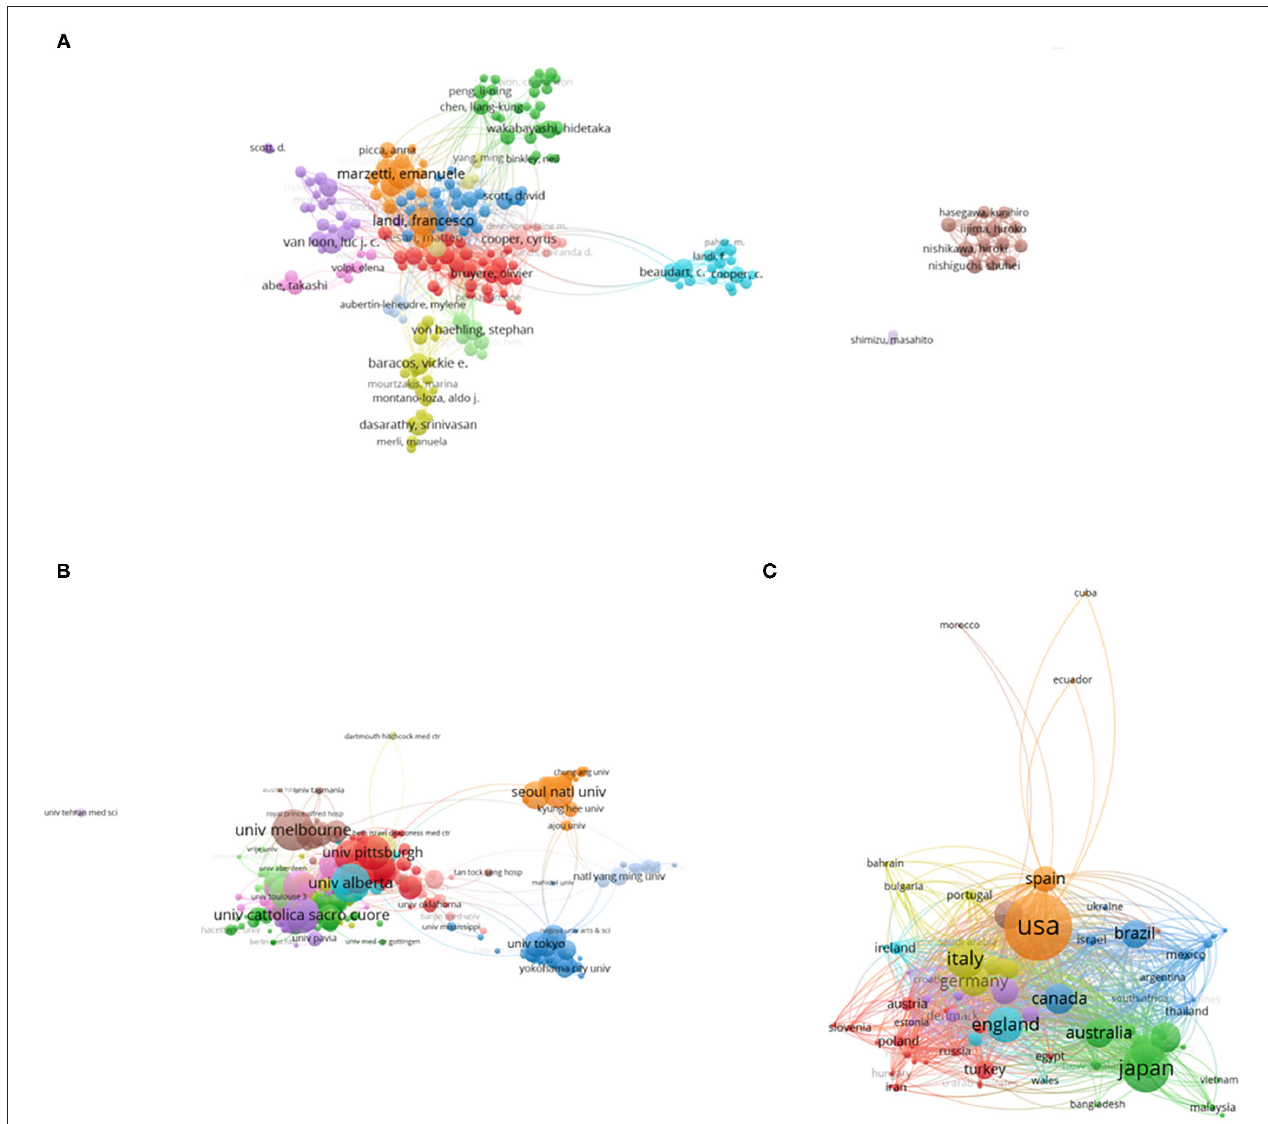
FIGURE 7 | Co-authorship analysis of global research about sarcopenia. (A) Mapping of the 245 authors co-authorship analysis on sarcopenia. (B) Mapping of the 461 institutions co-authorship analysis on sarcopenia. (C) Mapping of the 74 countries co-authorship analysis on sarcopenia. The size of the points represents the co-authorship frequency. The line between two points in the figure represents that two authors/institutions/countries had established collaboration. The thicker the line is, the closer the collaboration between the two authors/institutions/countries